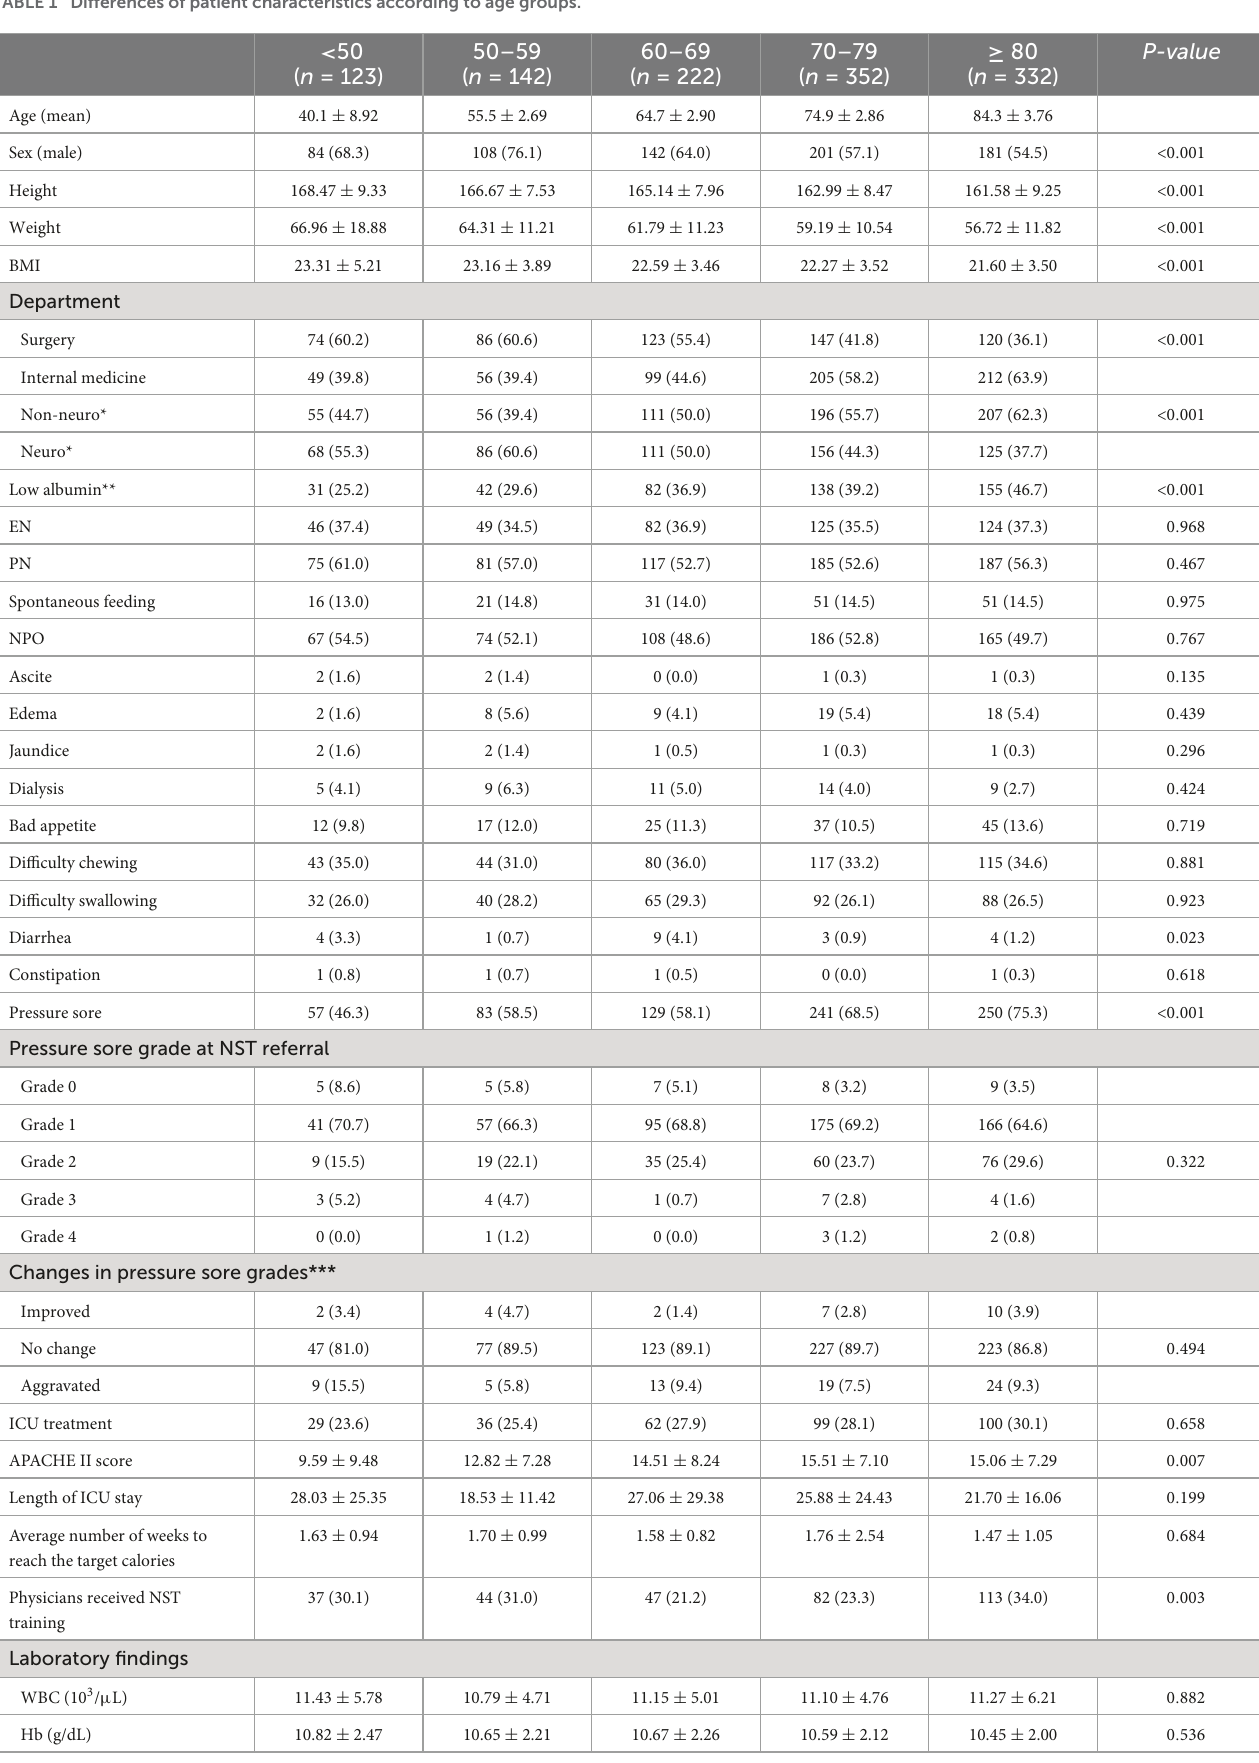
TABLE 1 Differences of patient characteristics according to age